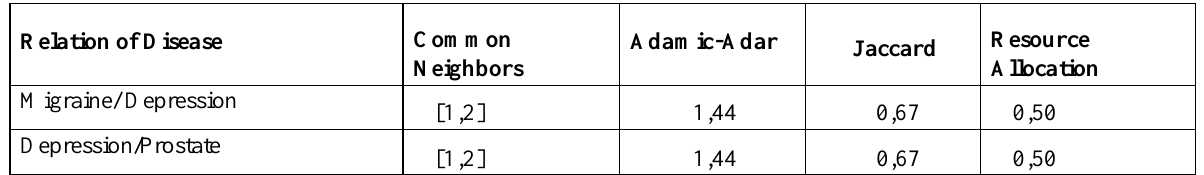
Table 3 : The Estimated values of the